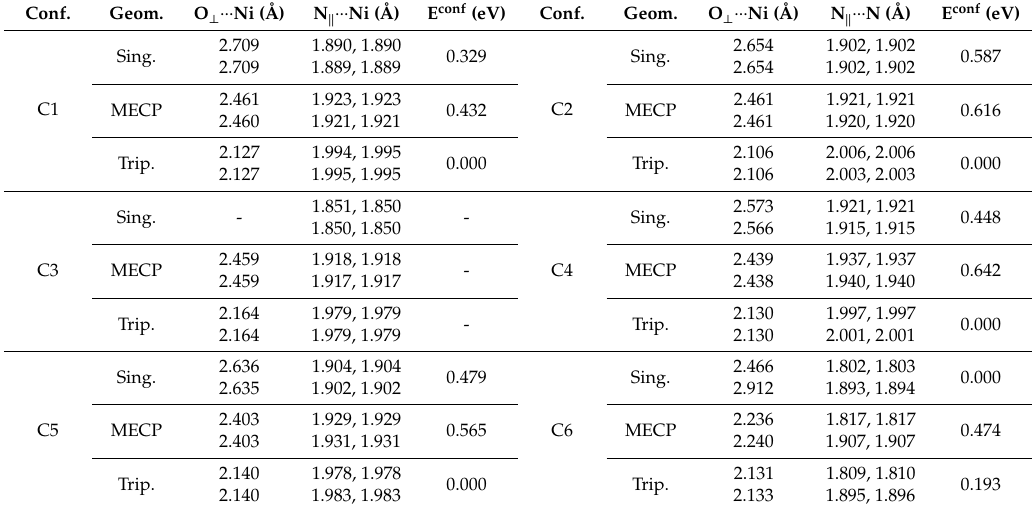
Table 1. The characteristic ligand bond distances (in Å) between the Ni(II) central atom and the oxygen or nitrogen atoms for singlet and triplet spin configurations, as well as for the minimum energy crossing point (MECP) geometries of the ground state singlet and triplet energies of the six proposed metal-organic complexes (C1–C6) obtained at M06 / def2-TZVP level of theory. The relative conformational energies (E conf in eV) between singlet, triplet, and MECP geometries are also given in the 5th and 10th